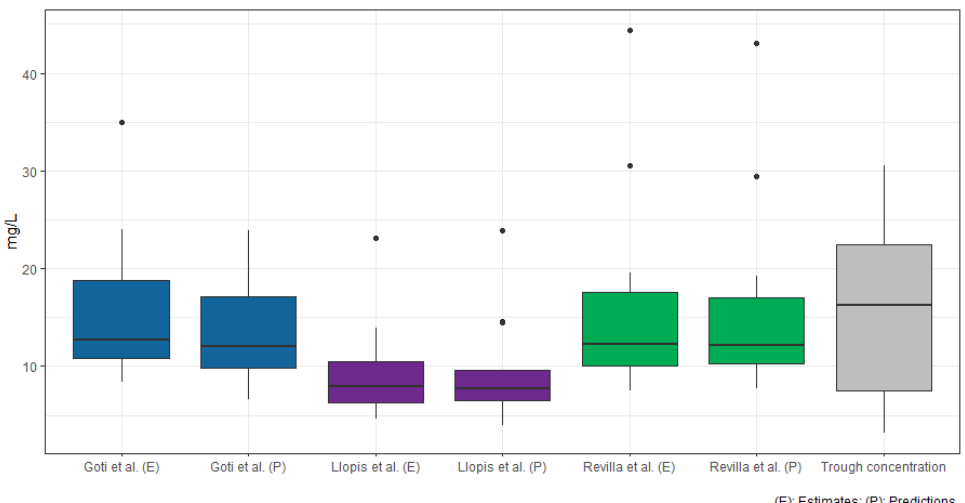
Figure 1. Boxplot for estimate predictions and trough concentration .